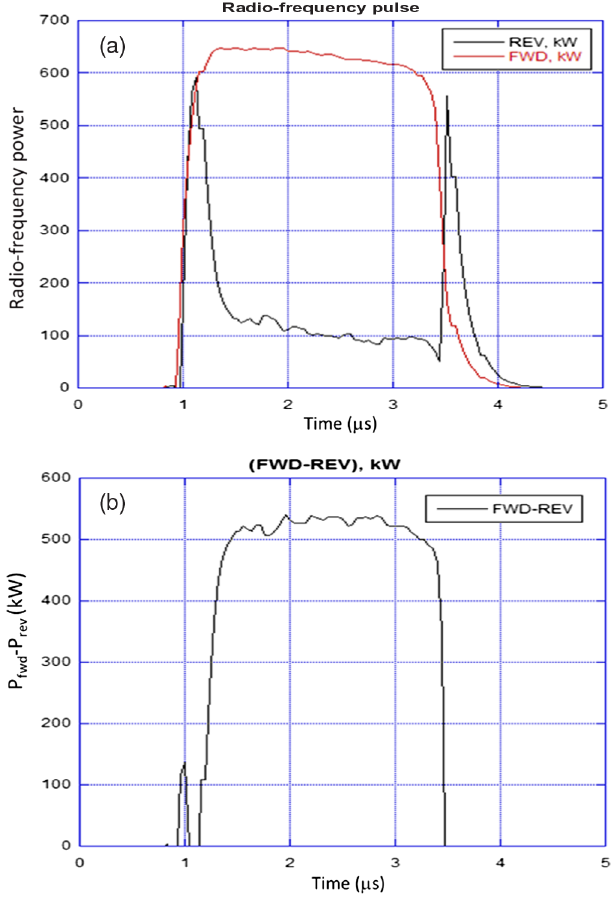
FRPMN030.FIG. 24. (a) Linac forward and reverse rf power trace; (b) differ- ence between the